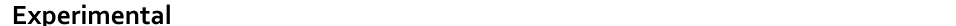
in yields and ee values while avoiding overoxidation and the generation of unwanted side products at more optimised flow rates. Experimental